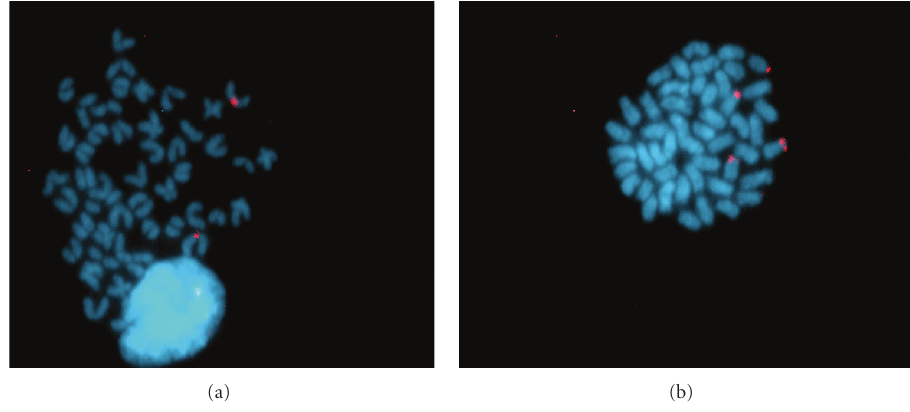
Figure 3: Localization of the myostatin-1 probe on S. aurata chromosomes. (a) MSTN-1 probe in the centromeric region of acrocentric chromosomes. (b) Localization of MSTN-1 and putative MSTN-2 genes both in centromeric regions of two di ff erent acrocentric